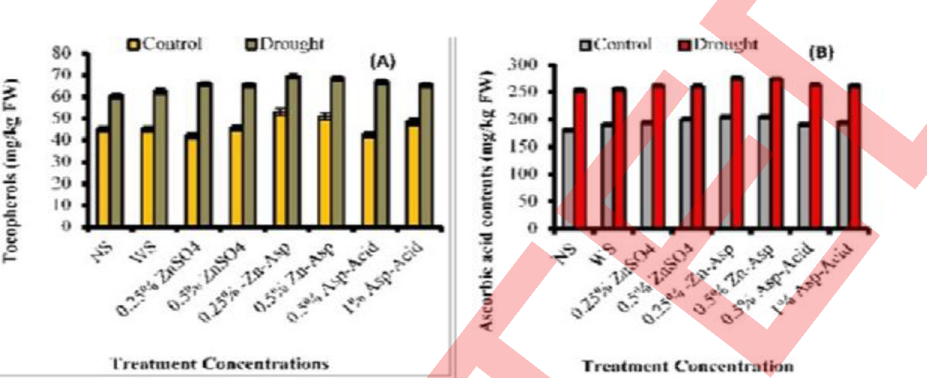
Fig 6. Effect of foliar sprinkled treatments of ZnSO 4 , Zn-Asp and L-Asp on status of Vitamin E and C (A) Tocopherol contents as Vitamin E (B) Ascorbic Acid Contents as Vitamin C of maize plants subjected to water stress in comparison with well-watered conditions (mean ± SE; n =